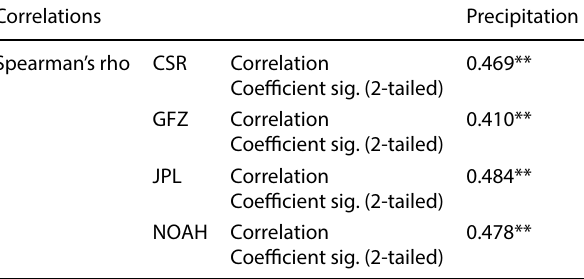
** Correlation is significant at 0.01